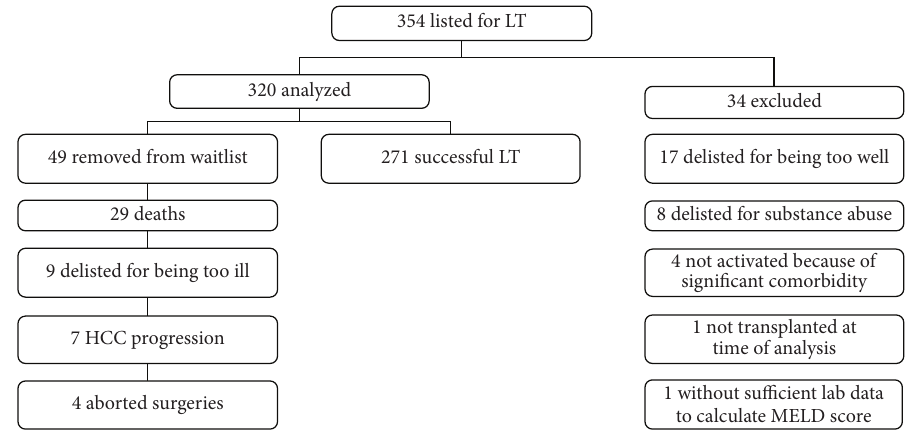
Figure 2: Flow chart of study subjects.